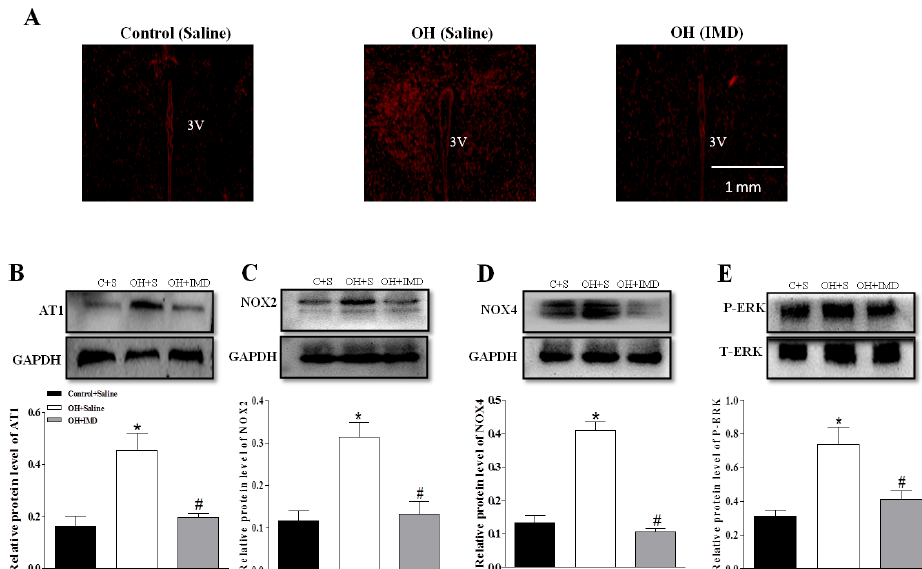
Figure 8. Effects of chronic application of IMD (50 pM, 0.11 µL/hr) in the PVN for 28 days on the protein expressions of AT1R ( B ), NOX2 ( C ) and NOX4 ( D ); ERK activation ( E ); and in situ ROS content ( A ) in the PVN in control and OH rats. Values are mean ± SEM. * p < 0.05 versus control (saline); # p < 0.05 versus OH (saline) ( B–E ). n = 3 or 4 for each group. C: Control, S: